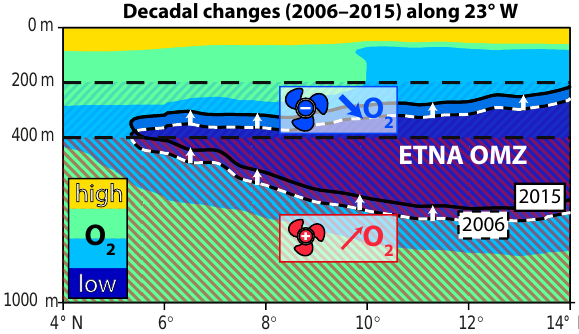
Figure 15. Schematic description of oxygen change associated with ventilation change in the ETNA along 23 ◦ W in the period 2006– 2015. The x axis indicates latitude; y axis indicates depth; color shading denotes the oxygen distribution (yellow: high oxygen; dark blue: low oxygen). In the depth layer 200–400m, ventilation has weakened, resulting in a strong oxygen decrease (indicated by the blue fan and the blue downward arrow with symbol O 2 ) . In the depth layer 400–1000m, moderate oxygen increase was found asso- ciated with a preceding strengthening of the ventilation (red fan and red upward arrow with symbol O 2 ) . As a result of the ventilation and oxygen changes, the ETNA OMZ has migrated upward (white arrows); the black–white dashed and black contour lines indicate the extent of the OMZ for the years 2006 and 2015,